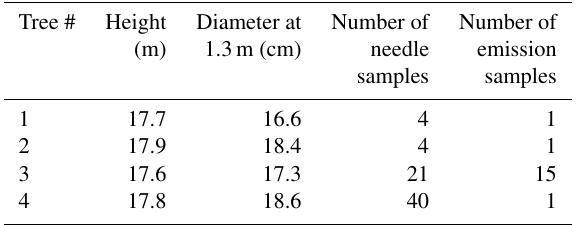
Table 1. Details of the trees examined and the sampling. Tree # Height Diameter at Number of Number of (m) 1.3m (cm) needle emission samples